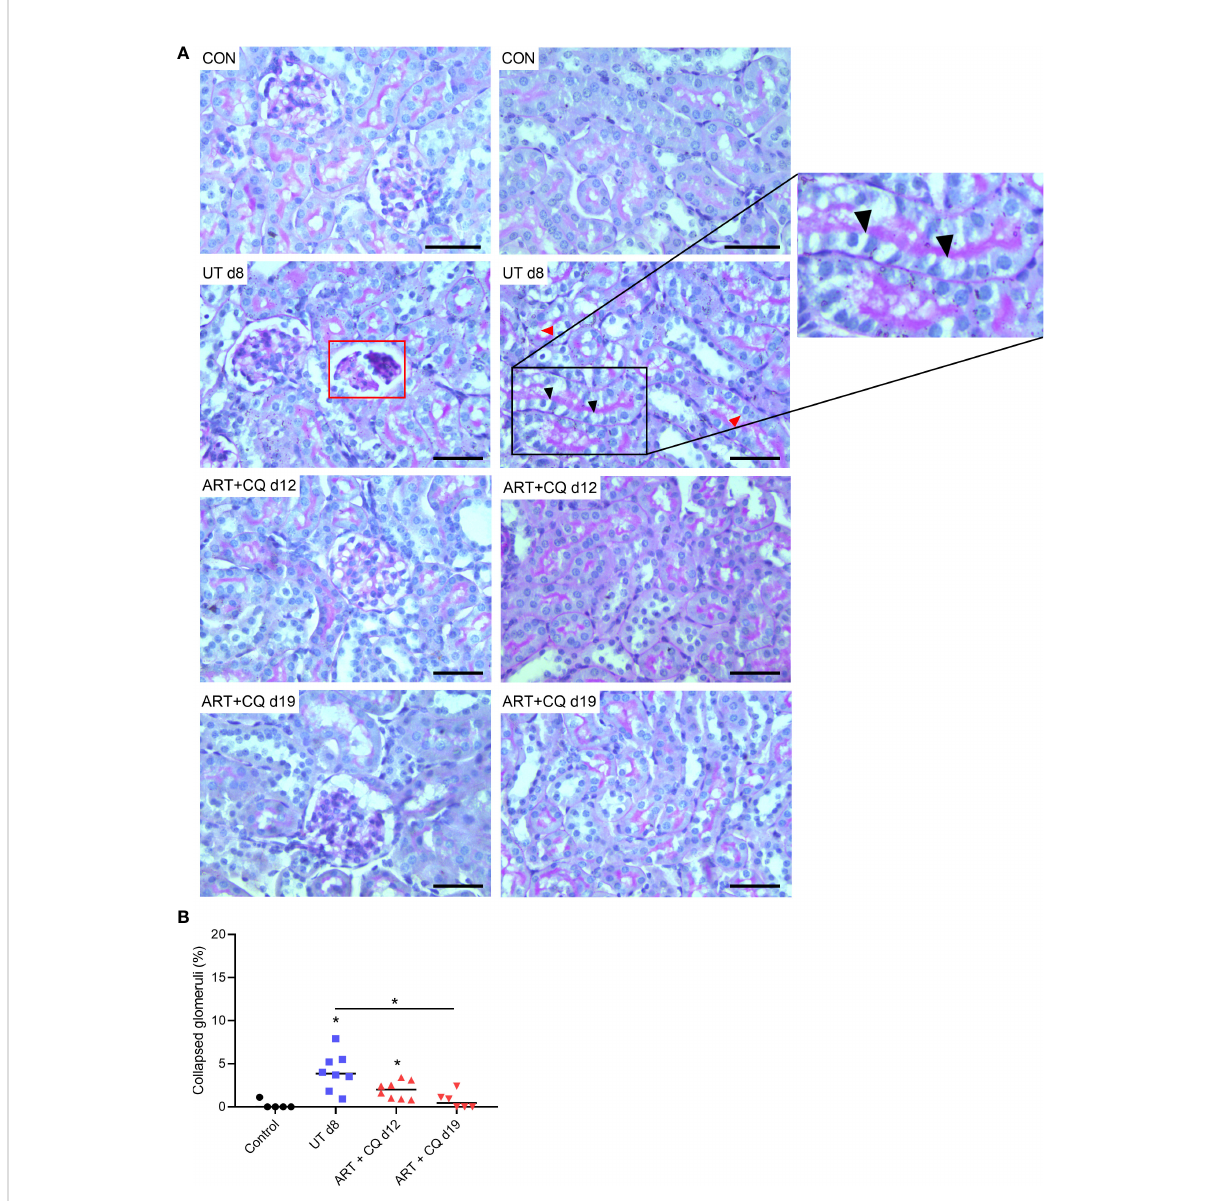
FIGURE 2 Antimalarial treatment decreased tubular injury and collapse of glomerular capillary tuft in kidneys of Pb NK65-E infected mice. C57BL/6 mice were infected with Pb NK65-E parasites and kidneys were dissected at the indicated times. From day 8 until day 12 p.i., mice were treated daily with antimalarial drugs (ART + CQ). (A) Sections were stained with PAS. Representative images are shown (original magni fi cation x40, bar = 50 µm). Red frames indicate collapse of glomerular tufts. Black arrowheads indicate vacuolization of proximal tubular epithelial cells, red arrowheads indicate loss of brush border of proximal tubular epithelial cells. (B) Percentage of glomeruli with collapsed glomerular tufts counted on PAS stained kidney sections Asterisks above data points indicate signi fi cant differences compared to control mice, asterisks above a horizontal line show signi fi cant differences between different time points, *p < 0.05. Data of two experiments, Control: n = 6, untreated Pb NK65-E infected mice (UT) d8: n = 8, ART+CQ d12: n = 8, ART+CQ d19: n = 6. Mann-Whitney U test with Holm-Bonferroni correction for multiple testing (number of tests = 6) was performed in panel (B)